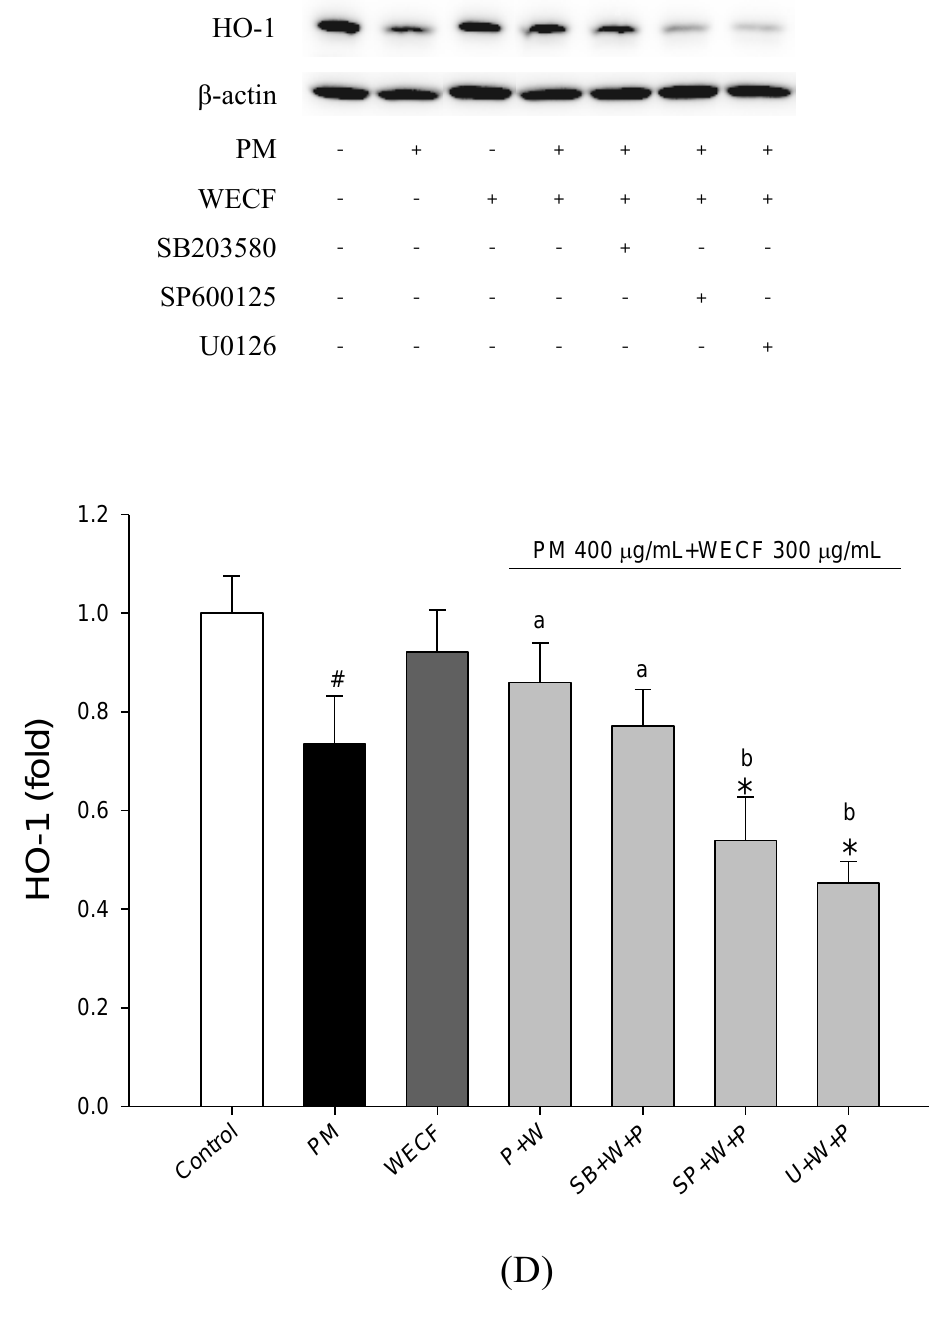
Figure 3. Effects of water extracts of djulis (WECF) on PM-induced Nrf2 and HO-1 protein expression in A549 cells. ( A ) Effects of WECF on PM-induced expression of Nrf2 in A549 cells. The cells were Fig. 3. Effects of water extracts of djulis (WECF) on PM-induced Nrf2 and HO-1 treated with WECF and exposed to 400 µ g/mL PM for 12 h. # ( p < 0.05) compared with the control protein expression in A549 cells. (A) Effects of WECF on PM-induced expression of group and * ( p < 0.05) compared with 400 µ g/mL PM-induced cells alone. ( B ) Effects of WECF on PM- induced HO-1 activity in A549 cells. The cells were treated with WECF and exposed to 400 µ g/mL Nrf2 in A549 cells. The cells were treated with WECF and exposed to 400 µg/mL PM PM for 15 h. # ( p < 0.05) compared with the control group and * ( p < 0.05) compared with 400 µ g/mL PM-induced cells alone. ( C ) Effects of p38 inhibitor (SB203580, SB), JNK inhibitor (SP600125, SP), and ERK inhibitor (U0126, U) on WECF-induced Nrf2 protein expression in PM-treated A549 cells. Control, cultured with medium alone for 12 h; PM, incubated with PM 400 µ g/mL for 12 h; P + W, incubated with WECF and PM for 12 h (WECF was added 30 min before PM); SB + W + P, SP + W + P, and U + W + P, treated as described for P + W except that the p38 MAPK inhibitor SB203580, the JNK inhibitor SP600125, or the ERK inhibitor U0126 were added to the medium before WECF. # ( p <